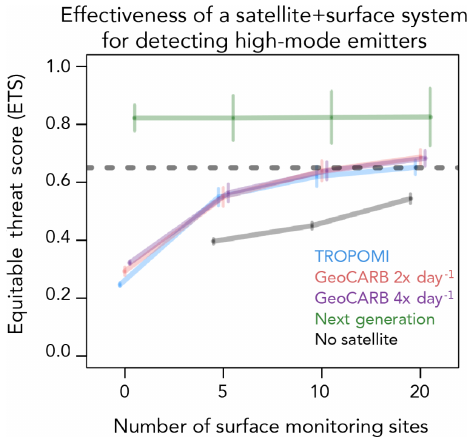
Figure 9. Effectiveness of a combined satellite and surface observ- ing system for detecting high-mode emitters in an oil/gas field of 100 emitters over a 50 × 50km 2 domain, as determined from joint inversion of the observations. The dashed line represents the ETS success